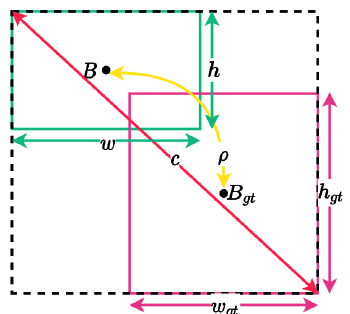
Figure 14. CIoU situations. ( ρ ): Euclidean distance between two centre points. ( B ): represents the centre points of the prediction box. ( B g ): represents the centre points of the ground truth box. t ( α ): The weight function. c: represents the diagonal distance of the minimum closure region that can contain both prediction frame and real frame. ( υ ): measures the similarity of aspect ratio.